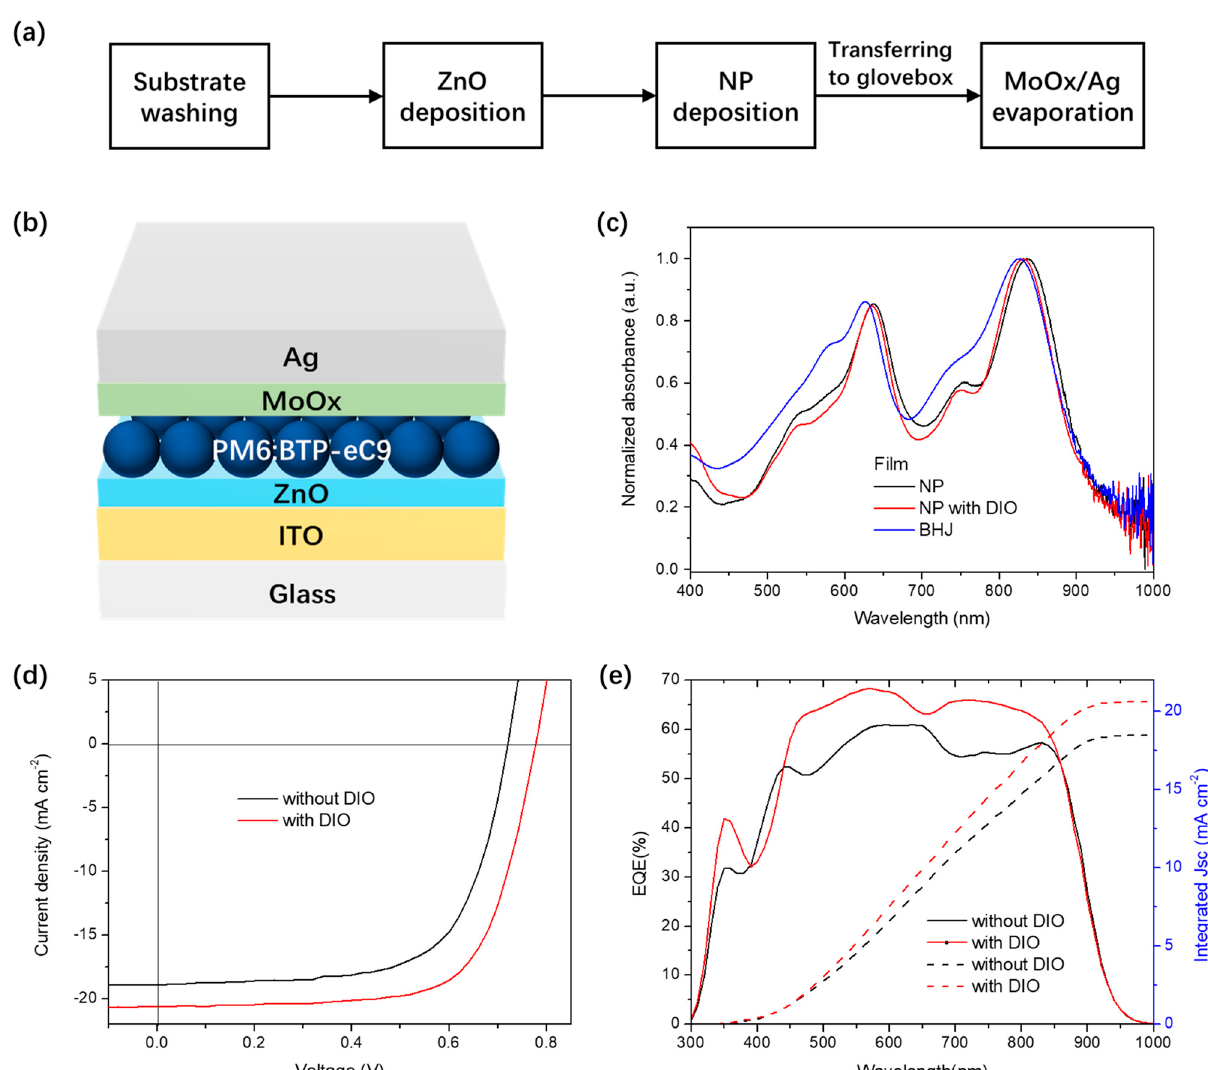
Figure 3. ( a ) Flowchart of PM6:BTP − eC9 ssNP solar cell fabrication; ( b ) device architecture of the PM6:BTP − eC9 ssNP solar cell; ( c ) normalized UV − vis absorption spectra of PM6:BTP − eC9 ssNP and chloroform solution − processed films; ( d ) J − V characteristics; and ( e ) EQE of PM6:BTP − eC9 ssNP processed solar cells with or without DIO.